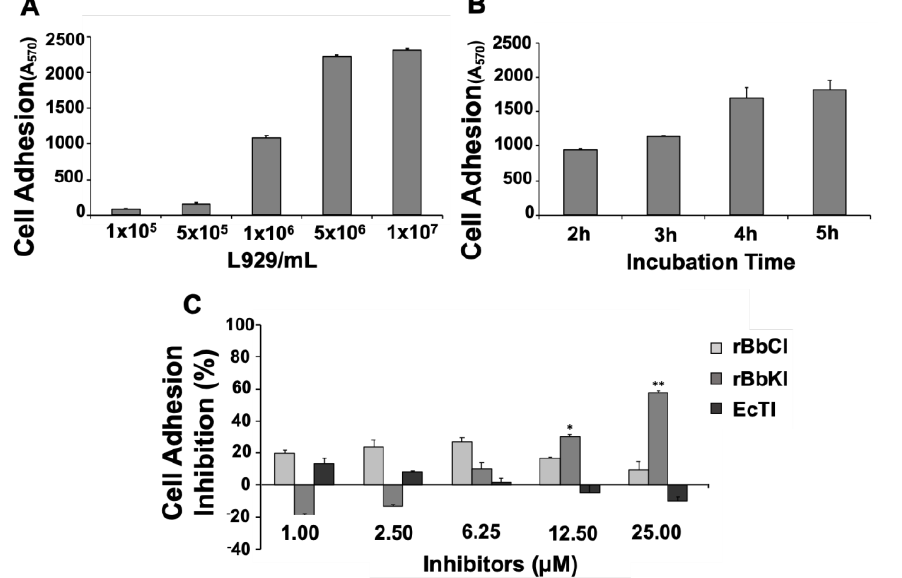
Figure 2. Action of rBbCI, rBbKI, and EcTI on cell adhesion of L929 cells. ( A ) Increasing concentrations of L929 were added to the 24-well plates previously coated with fibronectin and analyzed after 2 h of incubation. ( B ) 1 × 10 6 L929 cells were added to 24-well plates previously coated with fibronectin and analyzed at different incubation periods (2, 3, 4, 5 h). ( C ) L929 cells and increasing concentrations of rBbCI, rBbKI, and EcTI were pre-incubated for 15 min at room temperature and added to 24-well plates previously coated with fibronectin. Each bar represents the mean ± standard deviations of three repetitions. (* p < 0.05, ** p < 0.005, *** p < 0.0001; One way-ANOVA, follow Tukey ’ s Multiple Comparison Test).